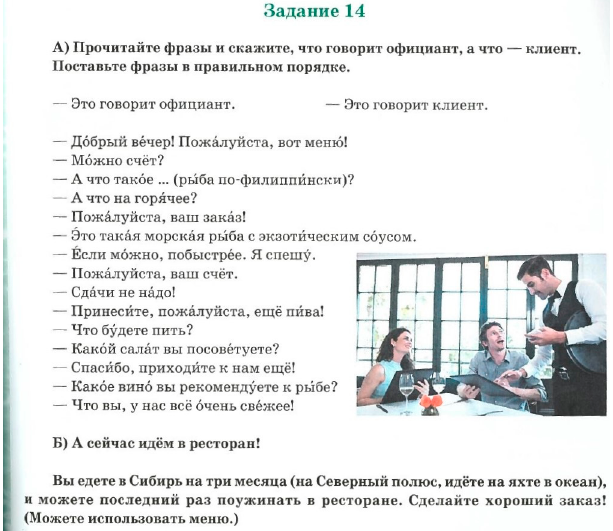
Figure 10. Example 2 of a task in Poyekhali .